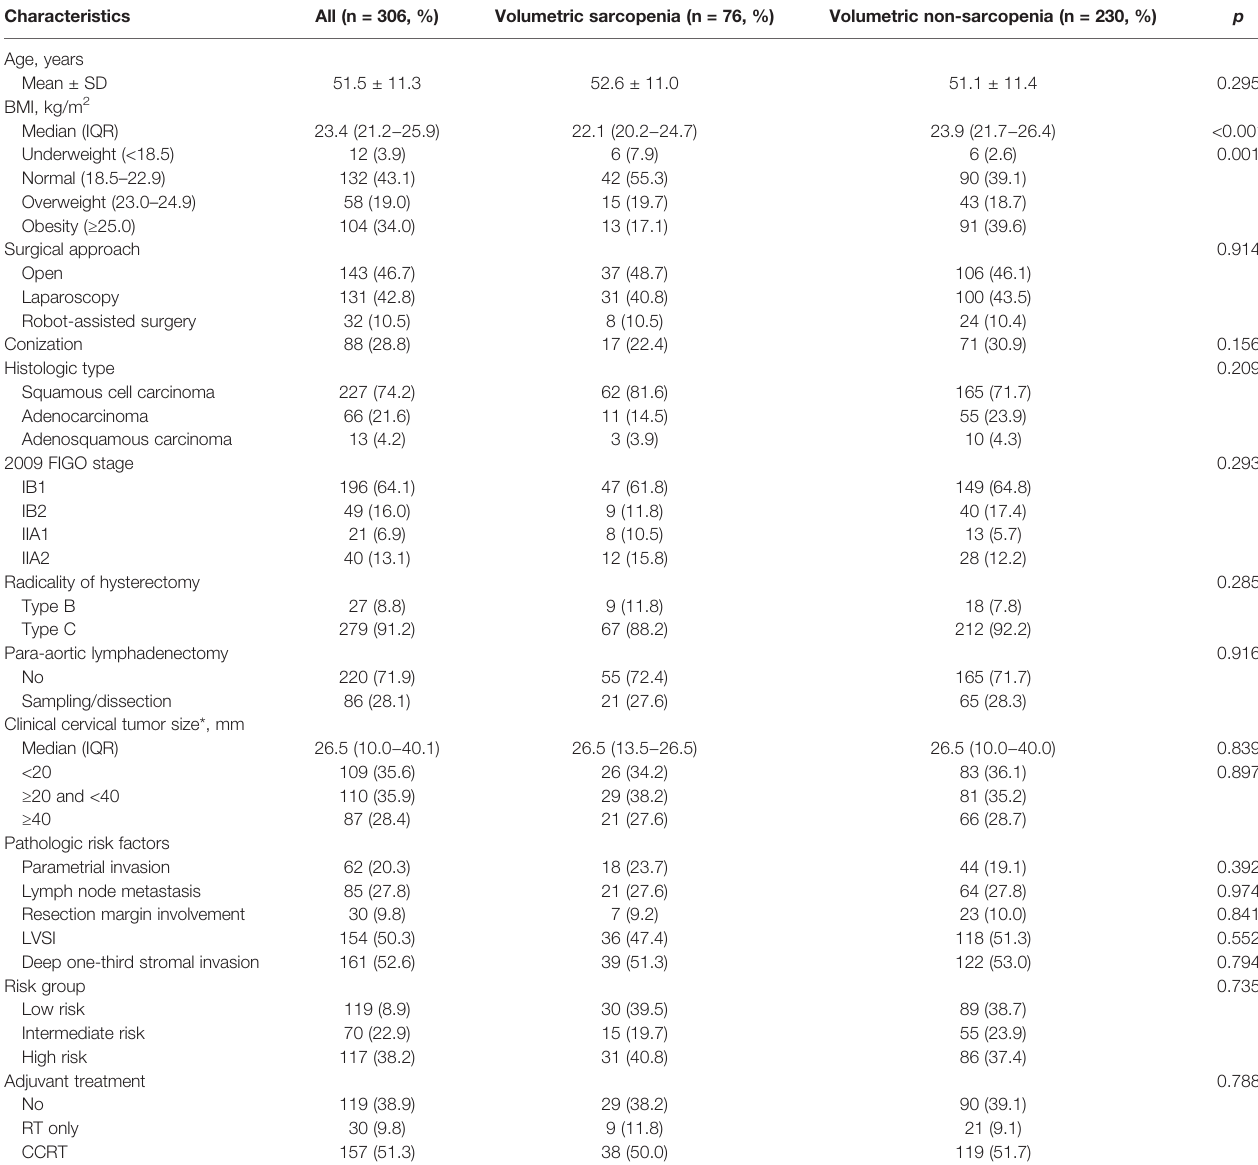
TABLE 1 | Clinicopathologic characteristics of volumetric sarcopenia and non-sarcopenia groups.